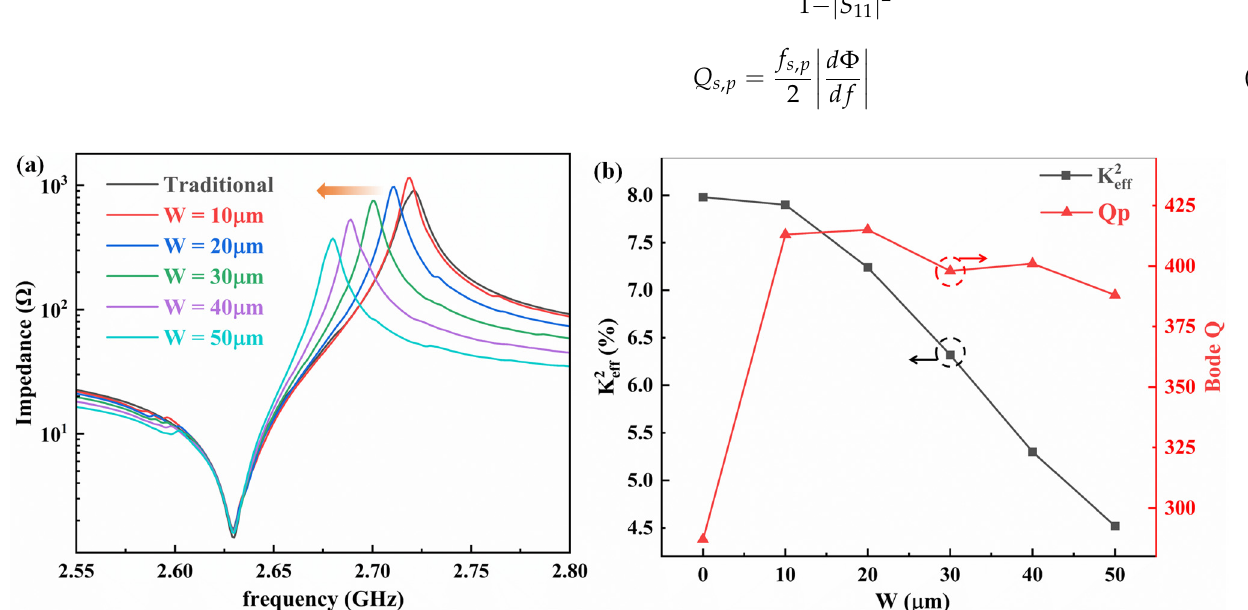
Figure 2. ( a ) The simulated impedance curves of the FBARs with support columns of different widths. ( b ) The performance dependence of FBARs with support columns of different widths.